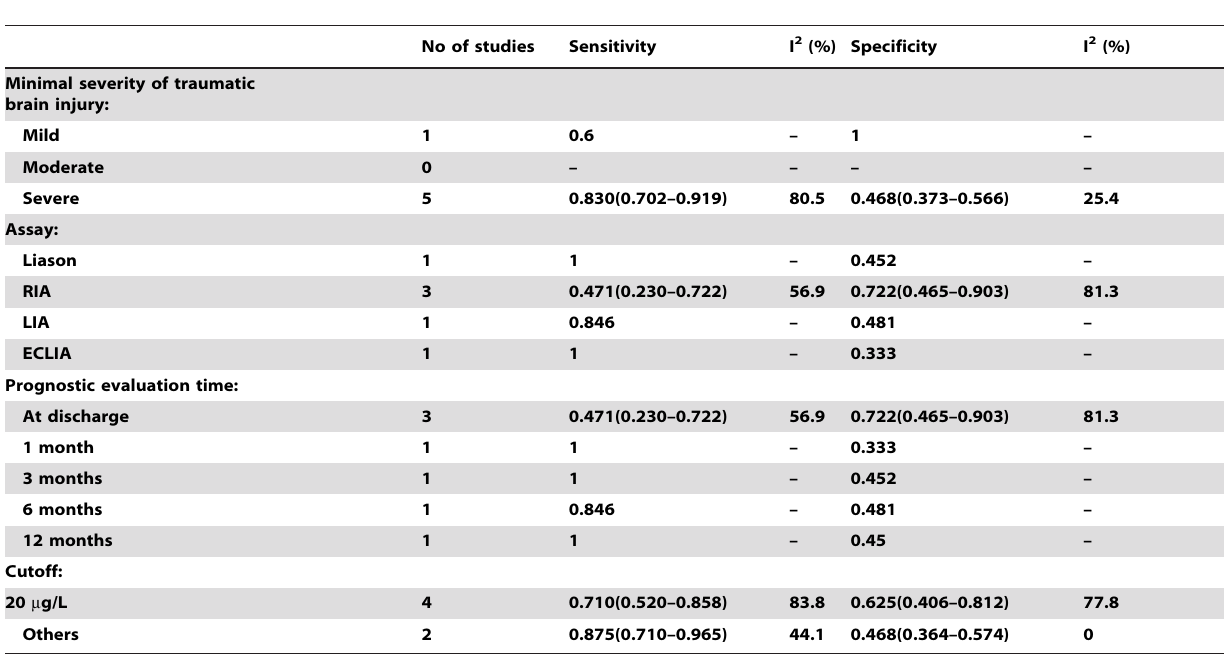
Table 4. Sensitivity analyses for the sensitivity and specificity of NSE concentrations to predict the mortality in patients with traumatic brain injury.